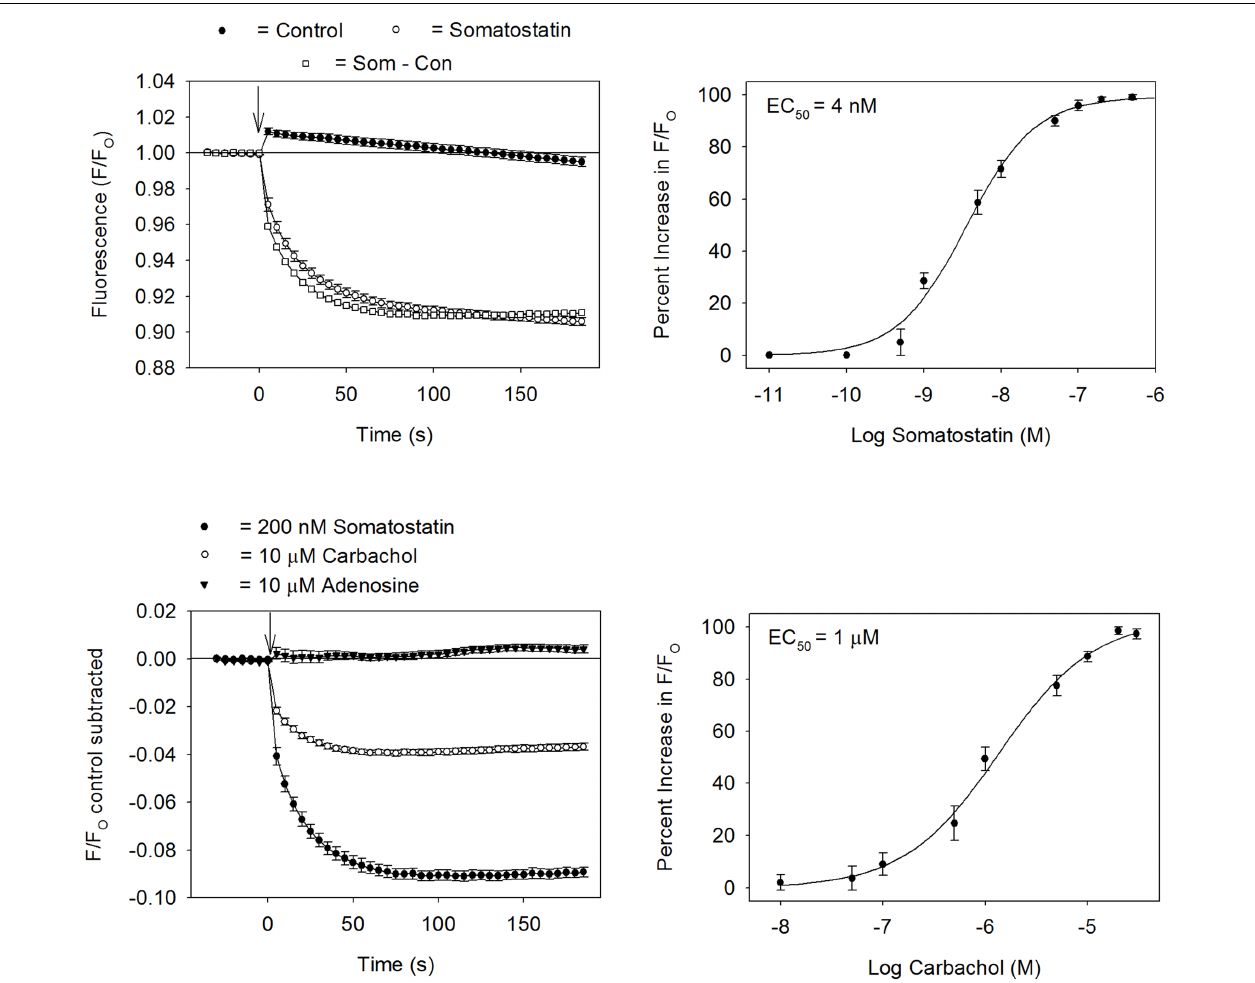
zero ( ↓ ).Top right panel: dose–response curve for the somatostatin-sensitive fluorescent signal (EC 50 = 4nM). Each point represents the mean ± SE of six measurements. Bottom left panel: changes in fluorescent signal obtained during injection of somatostatin, carbachol, and adenosine. Each point represents the mean ± SE obtained in six wells. Bottom right panel: dose–response curve for the carbachol-sensitive fluorescent signal (EC 50 = 1 μ M). Each point represents the mean ± SE of six